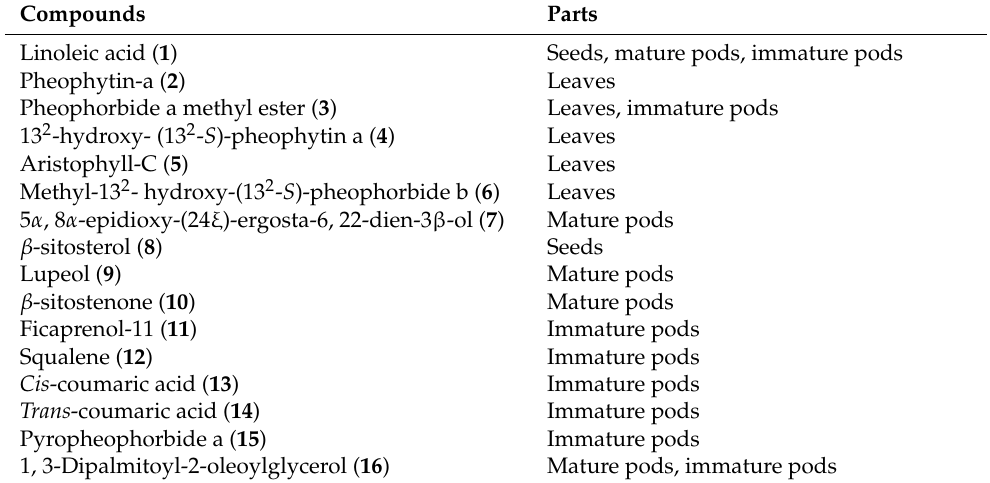
Table 1. A total of 16 compounds were isolated from different parts of L. leucocephala . Compounds Parts Linoleic acid ( 1 ) Seeds, mature pods, immature pods Pheophytin-a ( 2 ) Leaves Leaves, immature